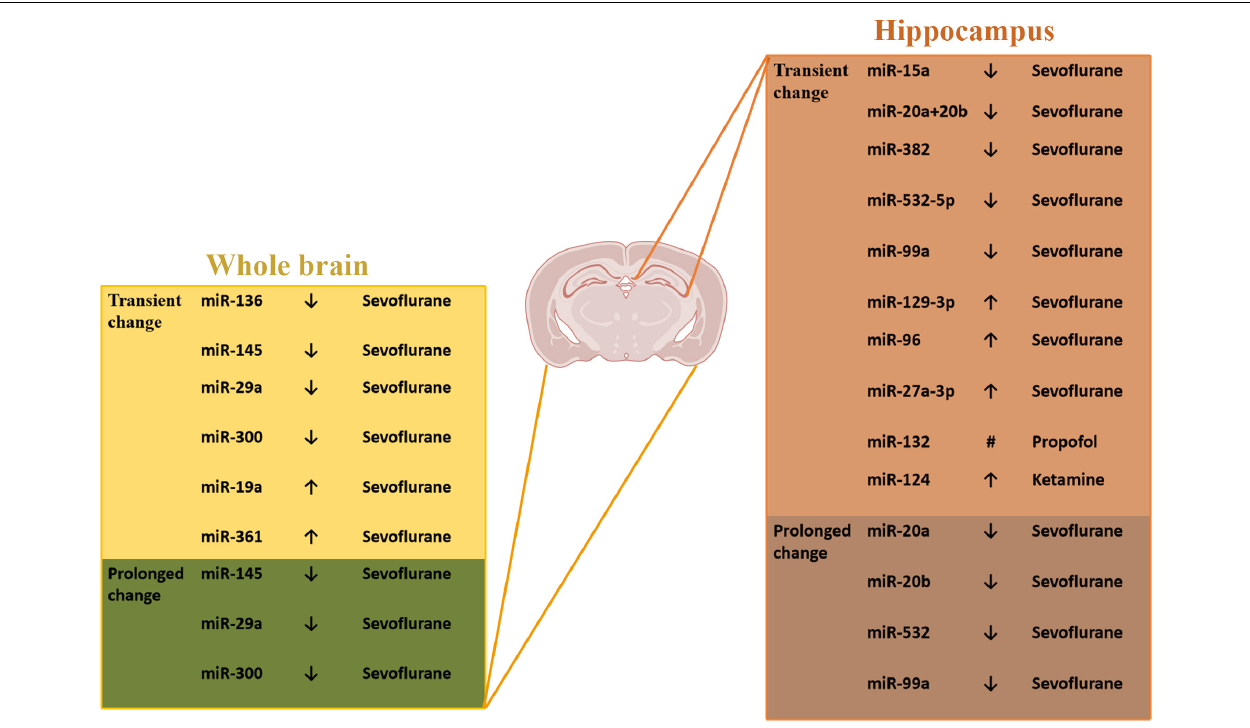
Frontiers in Molecular Neuroscience |